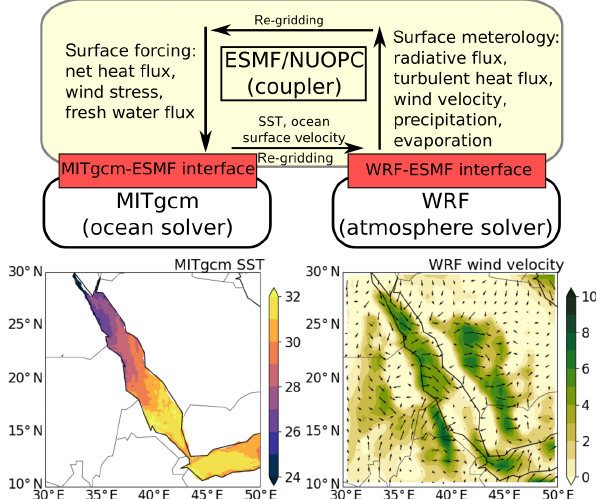
Figure 1. The schematic description of the coupled ocean– atmosphere model. The yellow block is the ESMF/NUOPC coupler; the red blocks are the implemented MITgcm–ESMF and WRF– ESMF interfaces; the white blocks are the oceanic and atmospheric components. From WRF to MITgcm, the coupler collects the at- mospheric surface variables (i.e., radiative flux, turbulent heat flux, wind velocity, precipitation, evaporation) and updates the surface forcing (i.e., net surface heat flux, wind stress, freshwater flux) to drive MITgcm. From MITgcm to WRF, the coupler collects oceanic surface variables (i.e., SST and ocean surface velocity) and updates them in WRF as the bottom boundary